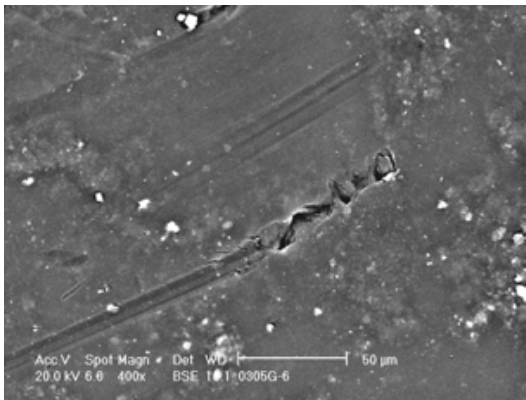
Figure 2. Sand particle abrasion (Reprinted with permission from [38]. Copyright 2011